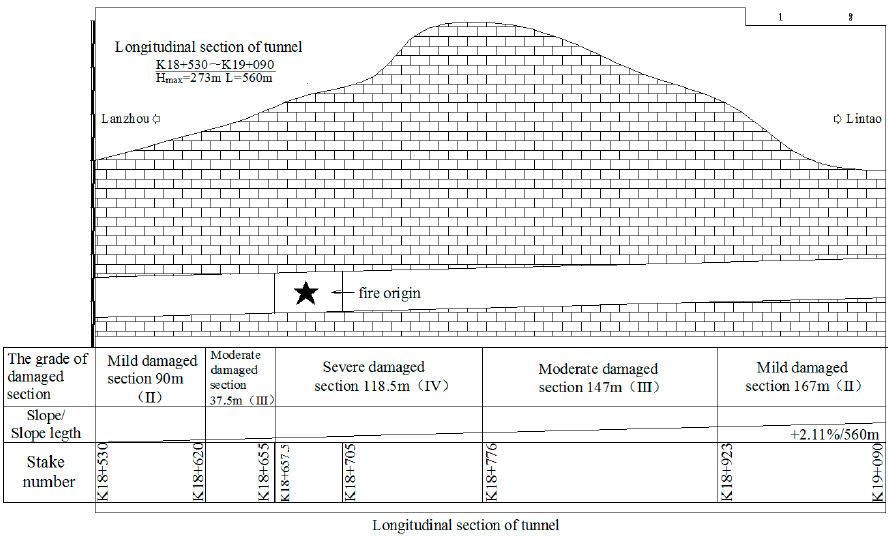
Figure 9. Damaged zone along the longitudinal direction of tunnel.